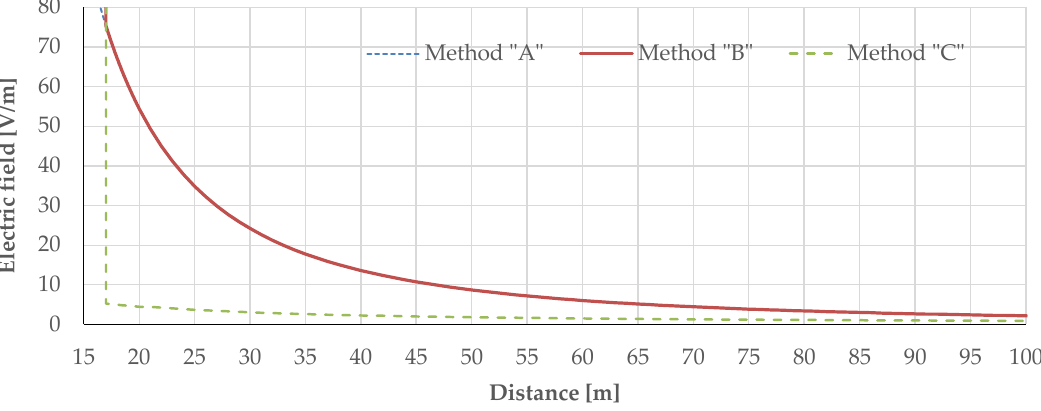
Figure 16. Electric field strength diagram, with respect to distance in the area very closely to the exterior of the breakwater ( r 2 = 17 m < r < 100 m), with three methods, “A”, “B”and “C”, for the case of Stachtoroi ( θ w = 0.2718 ◦ , θ = 210 ◦ , r 1 = 1.0 m, r 2 = 17.0 m, r 3 = 10.0 m, r ∞ = 150 km, ρ s = 1,000 Ω · m, ρ d = 100 Ω ·